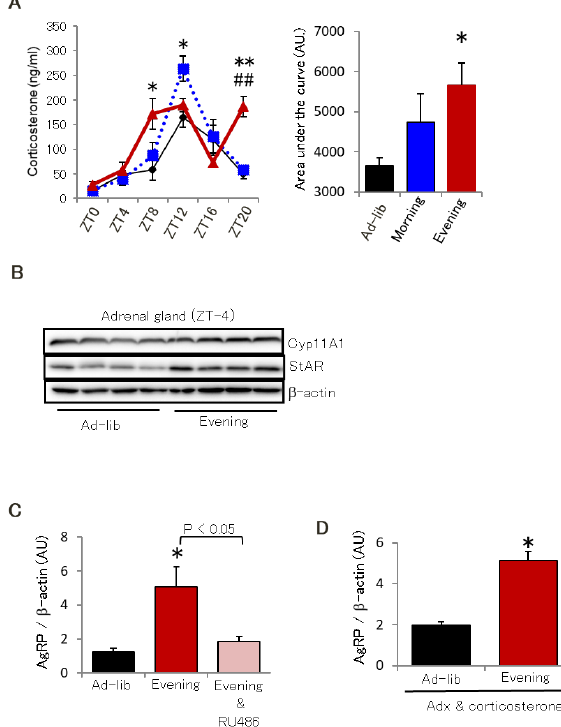
Figure 5. Hypo thalamic glucocorticoid sensitivity is critical for evening feeding-induced AgRP expression. ( A ) Circadian rhythm of plasma corticosterone levels (left) and areas under the curve (right) ( n = 4). ( B ) Two enzymes expression required for glucocorticoid synthesis, Cyp11a1 and StAR, in the adrenal glands ( n = 4). ( C ) Effect of oral administration of the glucocorticoid receptor antagonist RU-486 (20 mg/kg/day) for 2 weeks on AgRP expression of the hypothalamus ( n = 5). ( D ) Effect of adrenalectomy and 2 weeks of corticosterone supplementation (Adx) on AgRP expression of the hypothalamus ( n = 5). Data are presented as mean ± standard error. * p < 0.05 vs. Ad-lib group. ** p < 0.01 vs. Ad-lib group. ## p < 0.01 vs. Morning group.